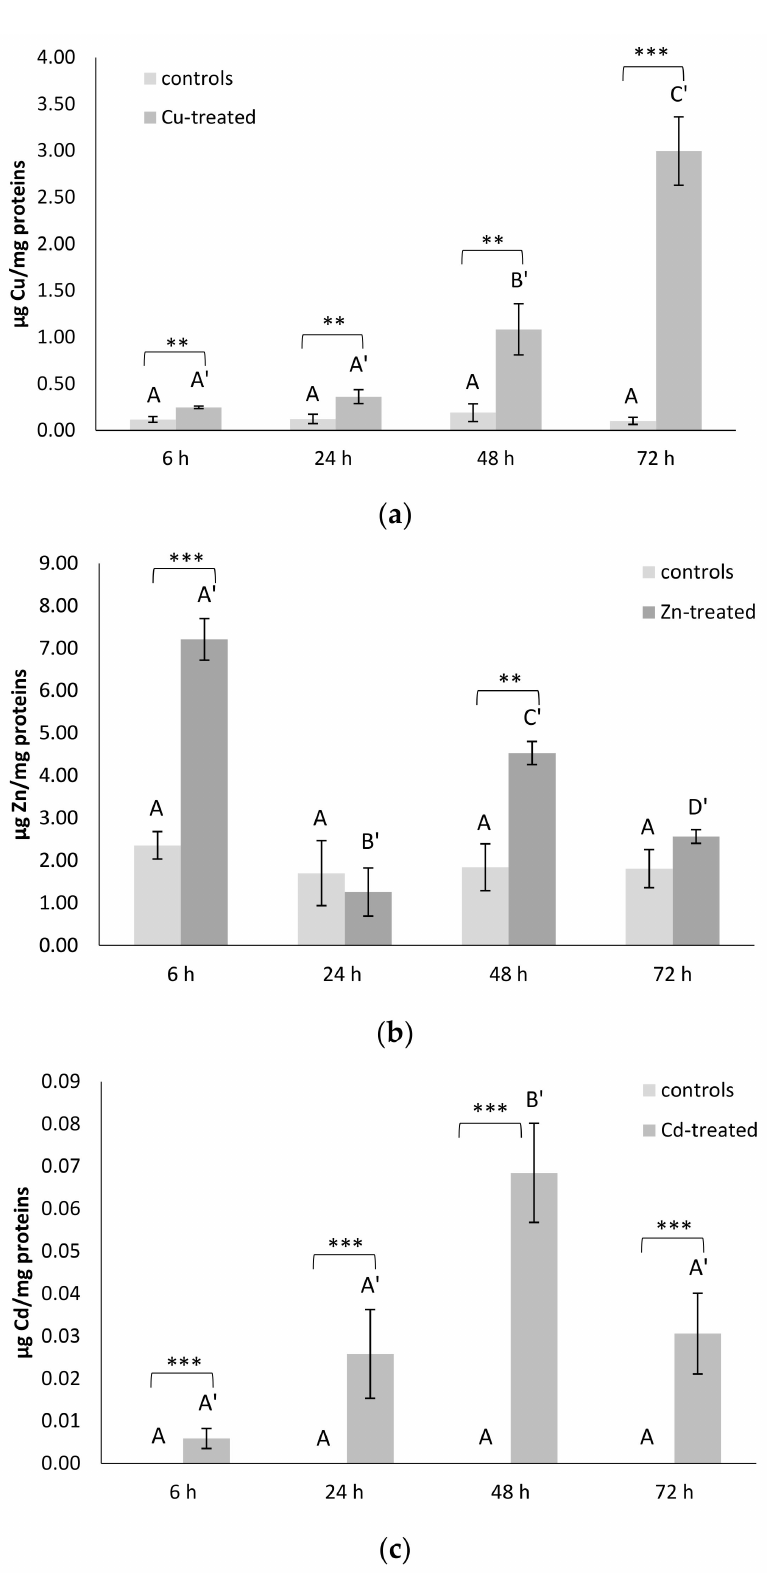
Figure 4. ( a ) Cu, ( b ) Zn and ( c ) Cd accumulation in the intestine of C. robusta ( µ g metal/mg total protein). Values are indicated as mean ± SD. Asterisks: significant differences with respect to controls (*** p < 0.001, ** p < 0.01). Different letters with the same index correspond to significant statistical differences ( p < 0.05) among different treatment times (Duncan’s